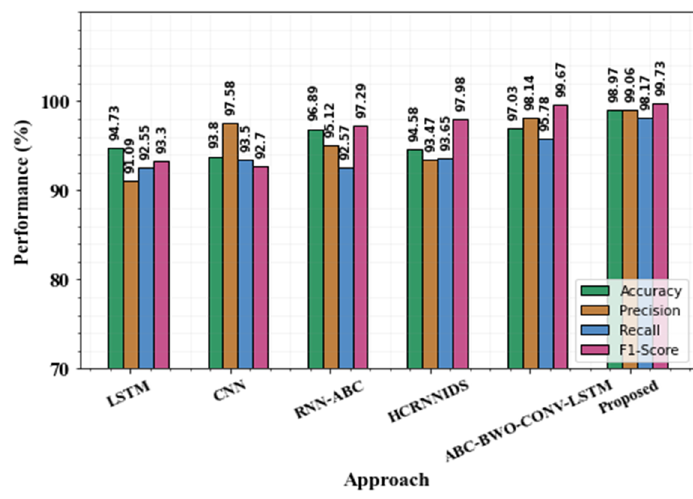
Figure 13. Evaluation of proposed with existing approaches.